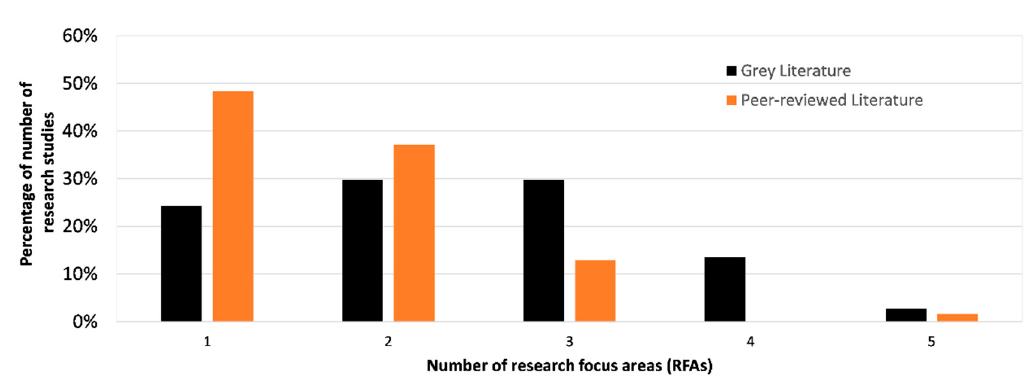
Figure 8. Number of research focus areas in grey and peer-reviewed studies. Water 2021 , 13 , 2138